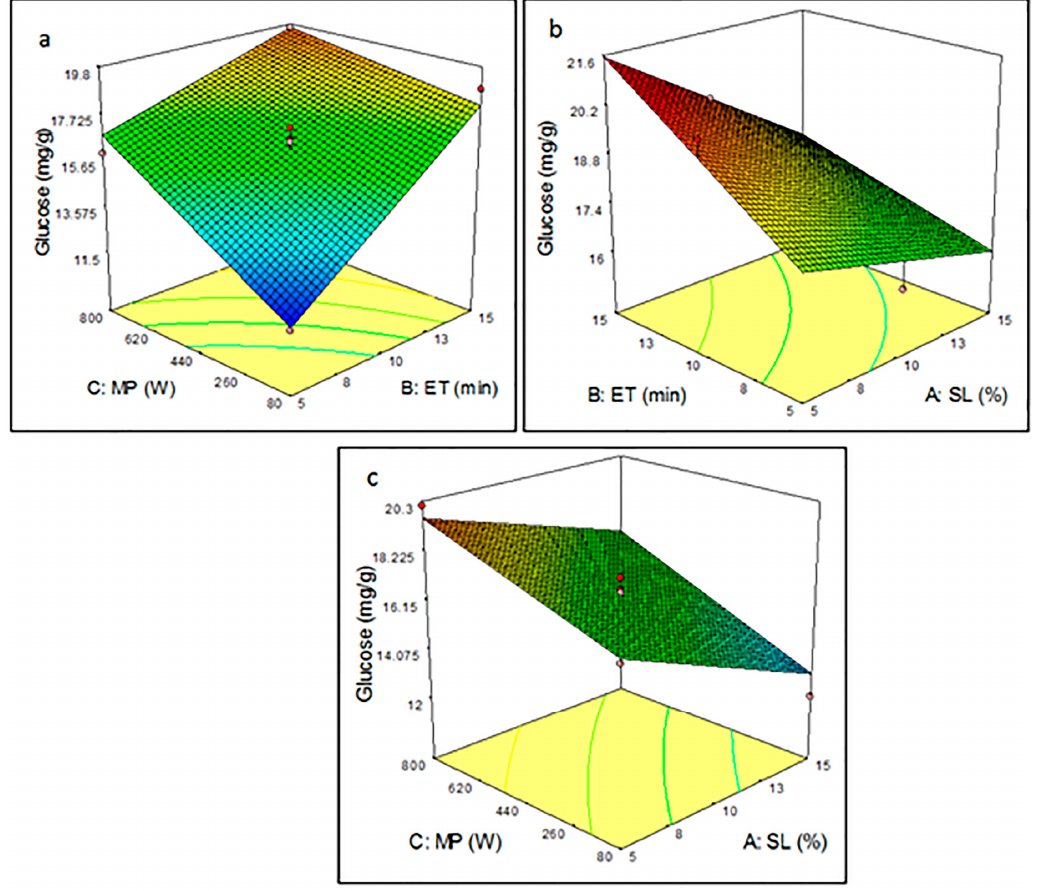
Figure 4. The effect of pretreatment parameters of MSB pretreatment on glucose yield ( a ) with MP and ET at a constant SL, ( b ) with ET and SL at a constant MP, and ( c ) with MP and SL at a constant ET.